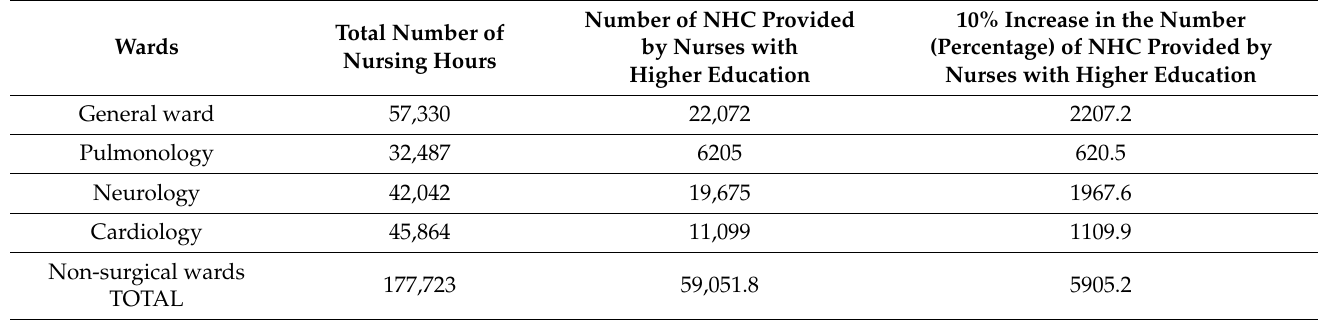
Table 2. Nursing care hours (NHC) before and after intervention.